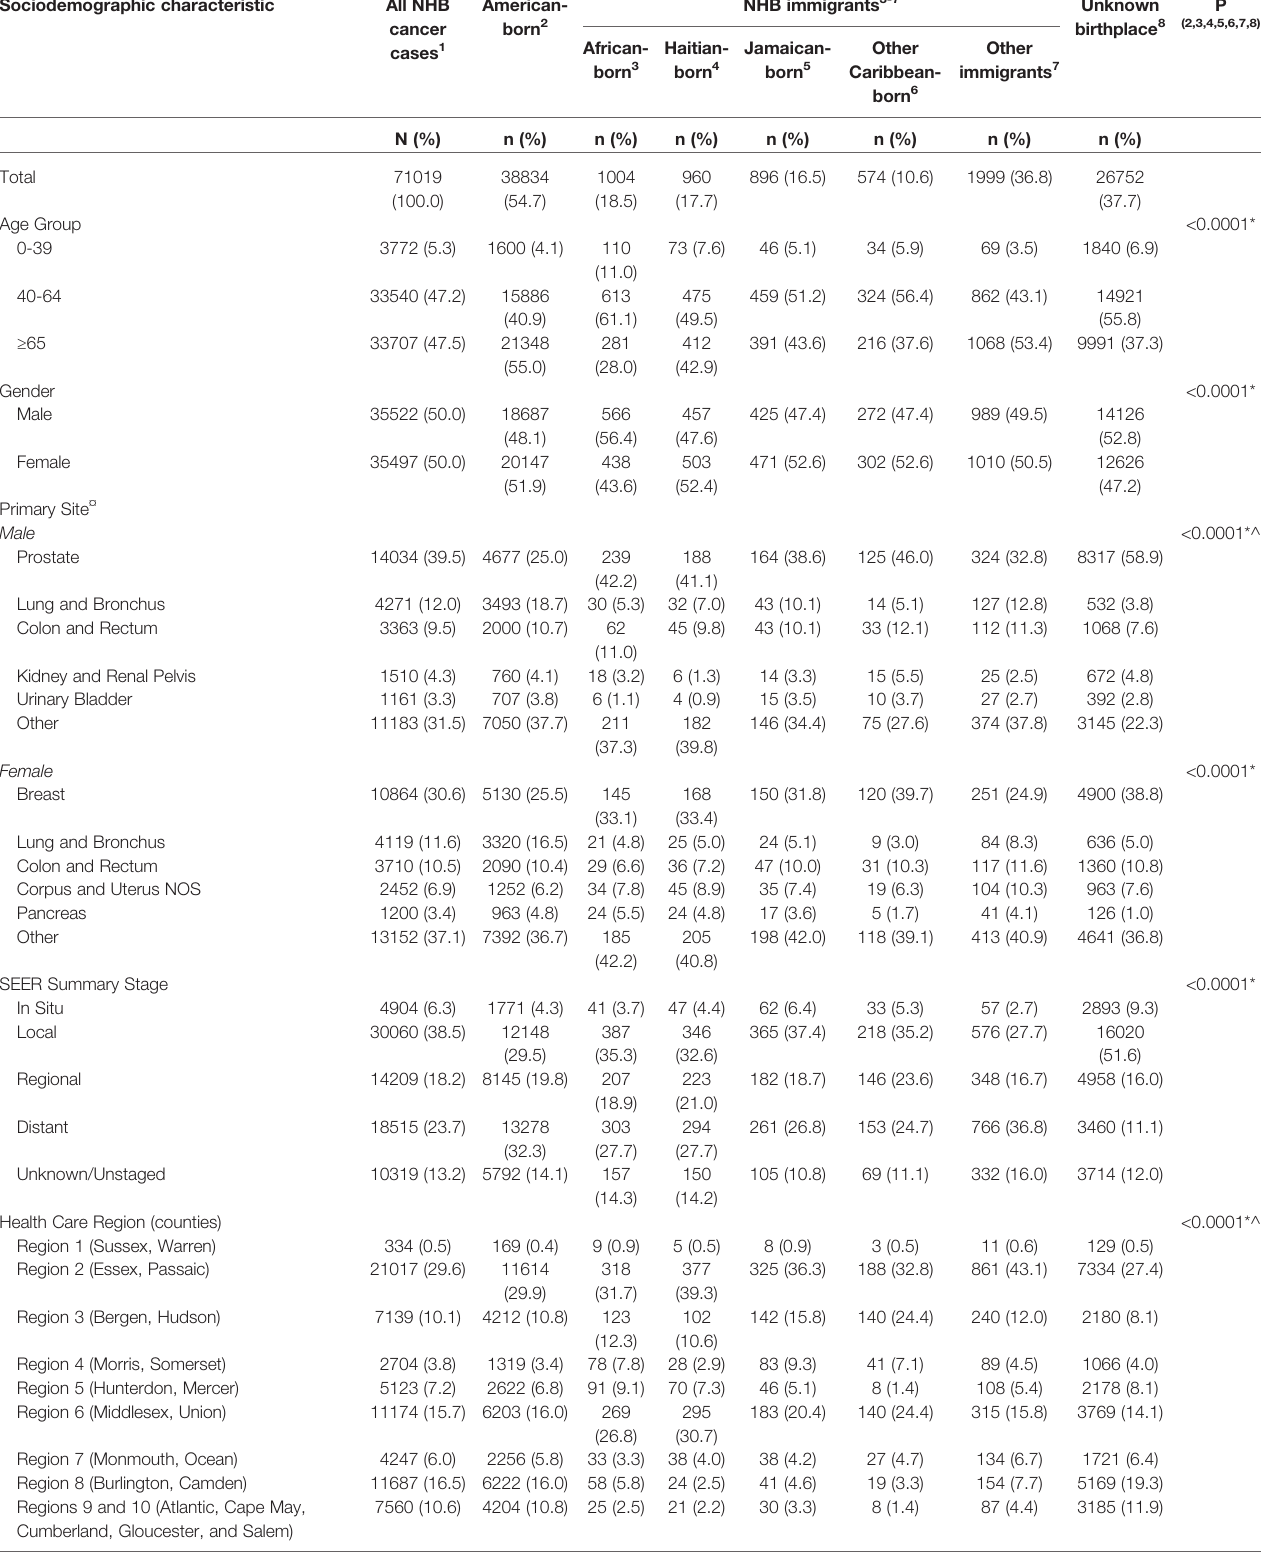
TABLE 1 | Descriptive statistics of non-Hispanic Black (NHB) cancer cases diagnosed in New Jersey by nativity and birthplace, 2005-2017. Sociodemographic